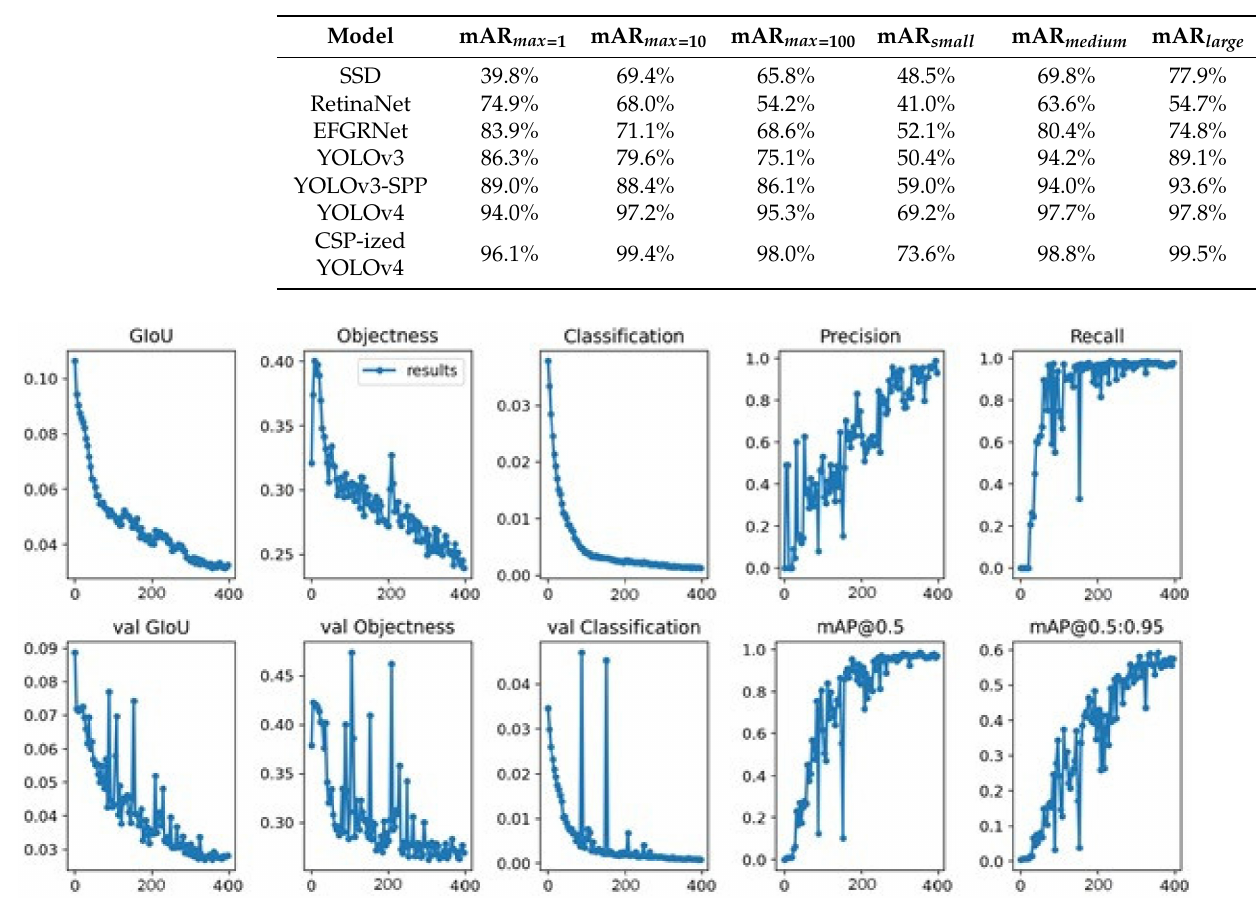
Table 2. Evaluation of one-stage object detection algorithms on the variant mAR score.